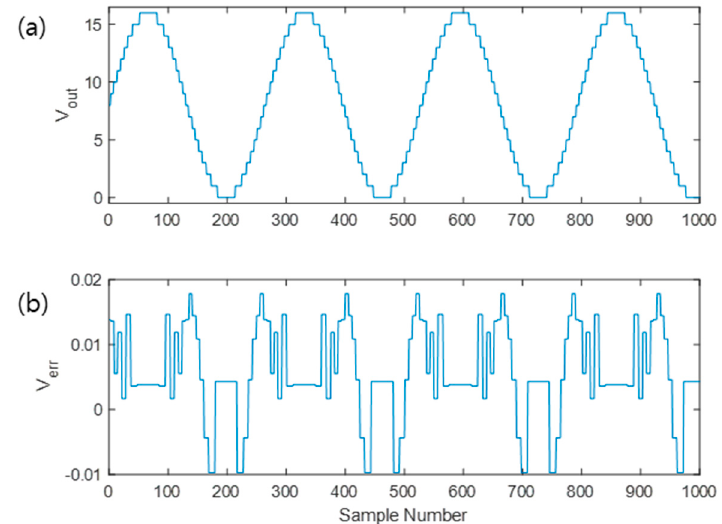
Figure 2. ( a ) DAC output waveform. ( b ) Waveform of DAC output error from capacitor mismatch without any mismatch error shaping.